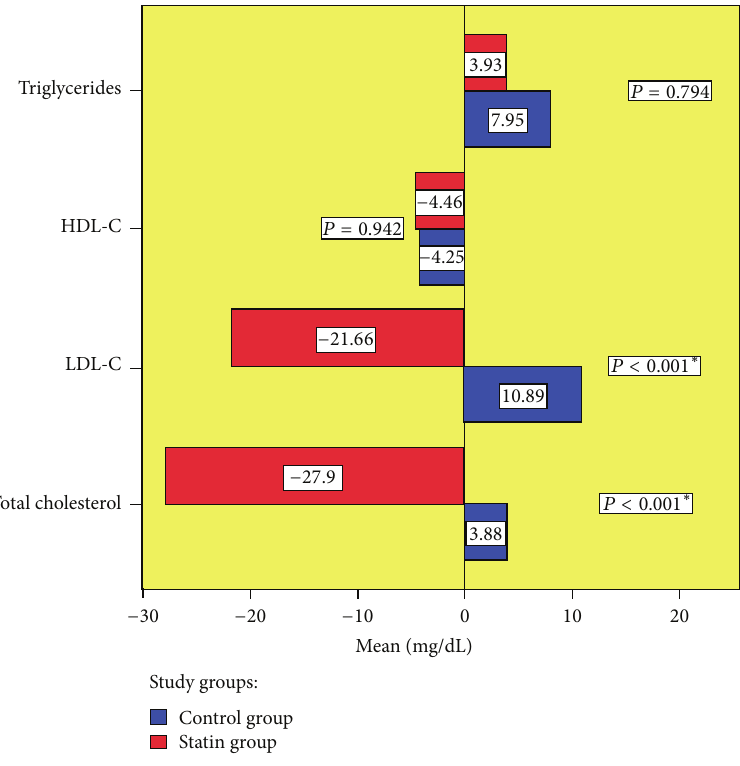
Figure 2: Evolution of lipid